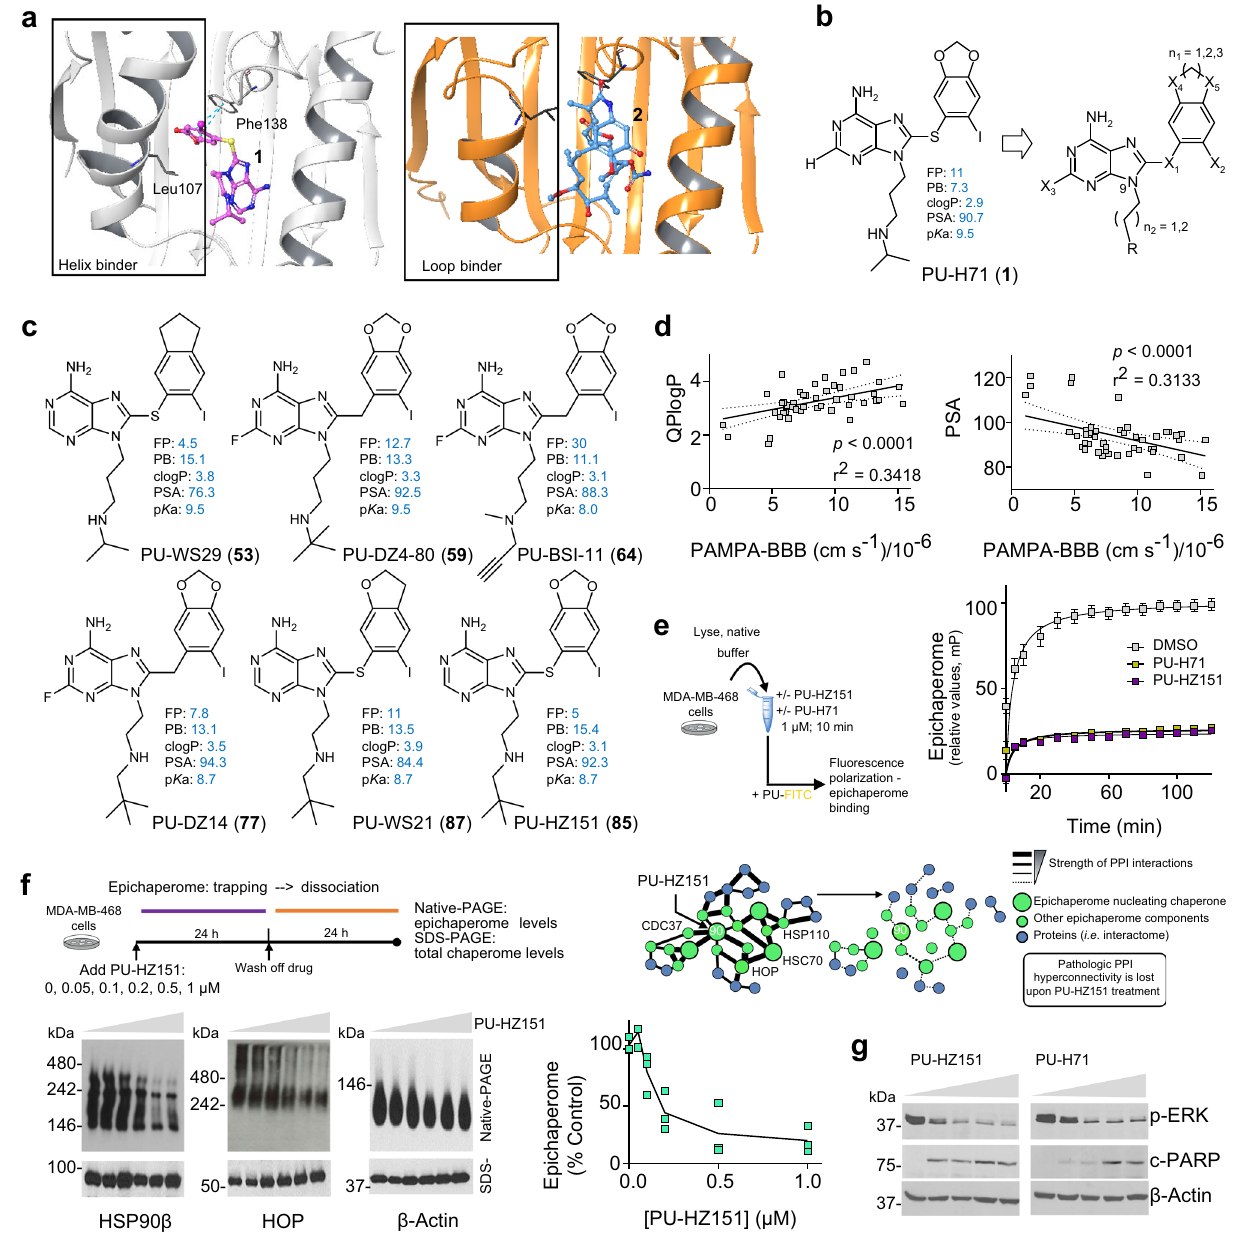
Fig. 1 Design and discovery of the CNS-directed epichaperome probes. a HSP90 crystal structure in complex with PU-H71 (1) (PDB ID: 2FWZ) or geldanamycin (2) (PDB ID:1YET) representing helical and loop binding conformations, respectively. b Schematic showing proposed sites for modi fi cation. c Chemical structure of potential CNS-targeted epichaperome probes and their determined af fi nity and permeability characteristics. Experimentally determined PAMPA-BBB (PB) permeability ef fi cient (Pe), 10 − 6 cm s − 1 and fl uorescence polarization (FP) EC50, nM values and calculated PSA, polar surface area, Å 2 ; acid dissociation constants, pKa and the logarithmic value of the 1-octanol/water partition coef fi cient (log P) are also shown. See also Supplementary Figs. 1 – 16 and Supplementary Table 6. d Correlative analysis between calculated compound properties and experimentally determined BBB permeability. Pearson ’ s r two-tailed, n = 47 individual compounds. e Competitive binding of PU-HZ151 to epichaperomes in MDA-MB-468 cell homogenates. Graph, mean ± s.e.m. of three replicates. f Biochemical analysis of epichaperome modulation by PU-HZ151 in the epichaperome-positive cell line MDA-MB-468. Representative gels and graphed data ( n = 3 individual data points are shown). Native PAGE shows the fraction of the chaperones incorporated into epichaperomes. SDS-PAGE shows the total chaperone levels. g Western blot analysis of MDA-MB-468 cells treated for 24 h with PU- HZ151 or PU-H71 (0, 0.1, 0.25, 0.5, and 1 µ M). c-PARP, cleaved PARP. Source data are provided as a Source Data fi le. (Fig. 1a). The differential binding mode in fl uences the kinetics of rates when compared to loop binders. The ‘ helix ’ conformation, ligand binding – ligands which induce (or capture) the helix while possibly a stochastic event in free HSP90, it may become conformation, termed ‘ helix-binders ’ , have lower association and enriched in disease when HSP90 becomes incorporated into dissociation rate constants for binding to HSP90 than ‘ loop- epichaperomes 7,17,20 . With this in mind, we designed our ligands with PU-H71 as a starting point for medicinal chemistry efforts binders ’ 32 . Helix binders can reach two-log slower dissociation NATURE COMMUNICATIONS| (2021) 12:4669